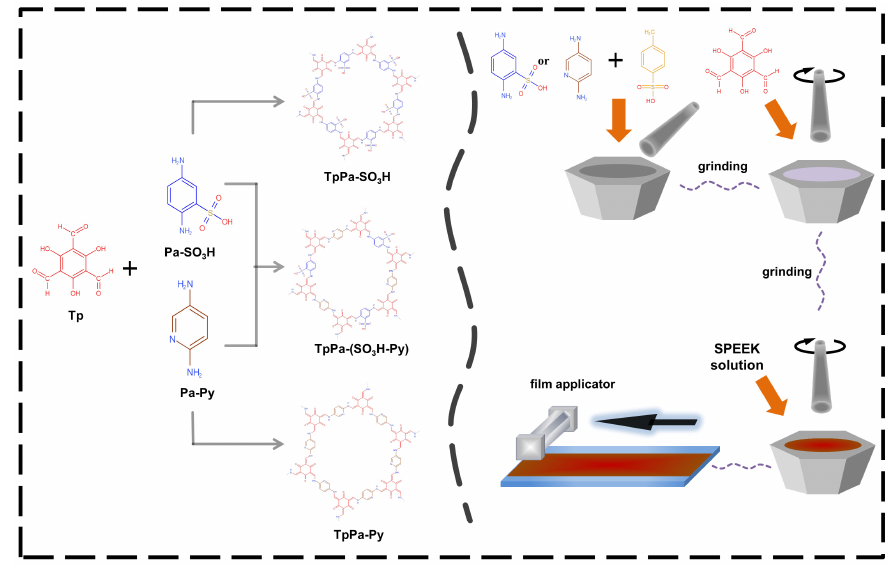
Scheme 1. Synthetic route of SPEEK/COFs composite